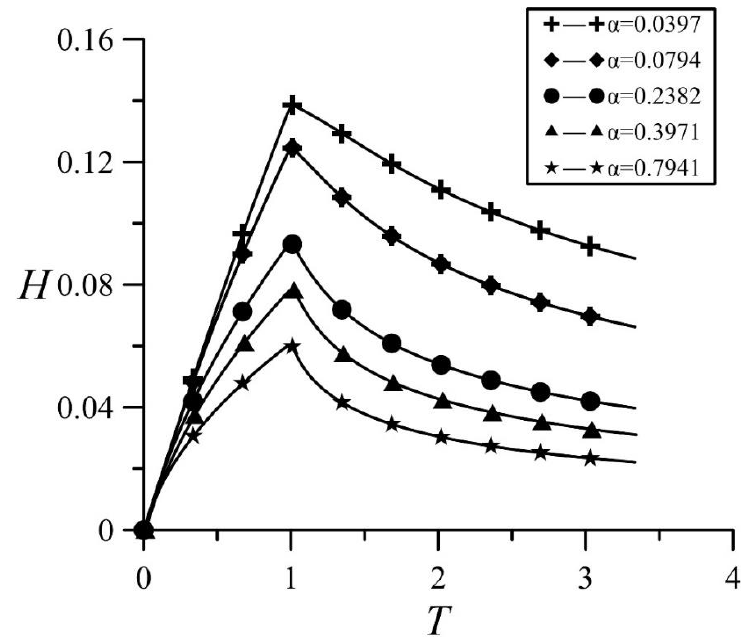
Figure 3. The groundwater level changes with different permeability factors 𝛼 ( X = 0.2 and U = 0).